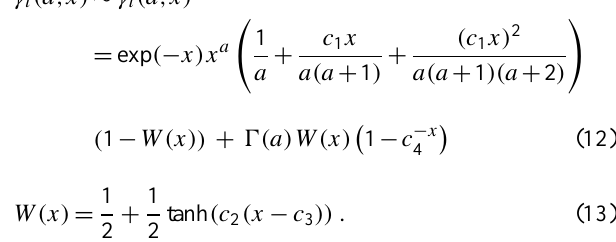
The necessary span of the table with respect to x at a cer- tain value of a may be taken from 0 to the value x 995 where 20 P(a,x 995 ) = 0 . 995 .x 995 as a function of a may be